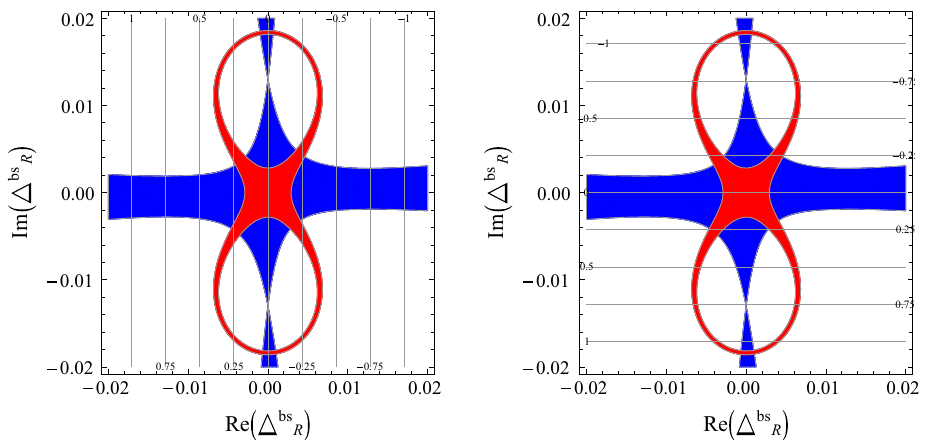
Fig. 2 Left ( right ): contours of the real (imaginary) part of ˜ C Z (cid:3) region is allowed from the bounds on (cid:5) M B